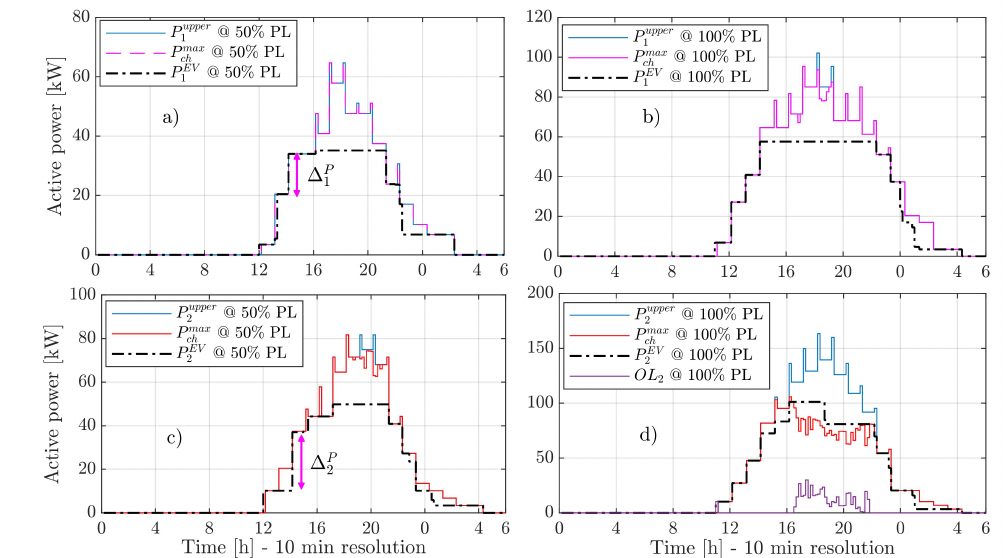
Figure 2. Optimal charging profile for a moderate and critical penetration level: ( a , b ) aggregator 1 and ( c , d ) aggregator